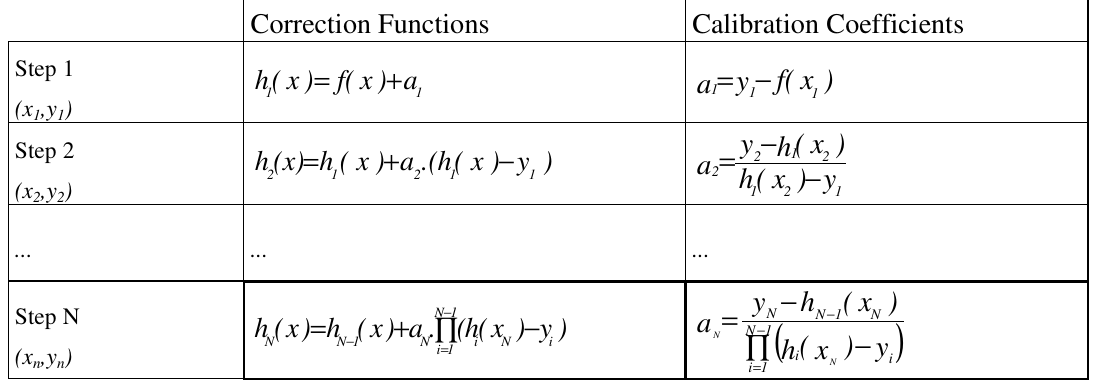
Table-1. Correction functions and calibration coefficients.